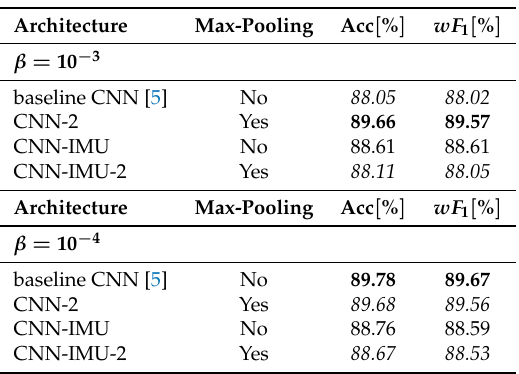
Table 6. Validation accuracies and Weighted F1 for the architectures with and without max-pooling operations on the Opportunity-Locomotion dataset.